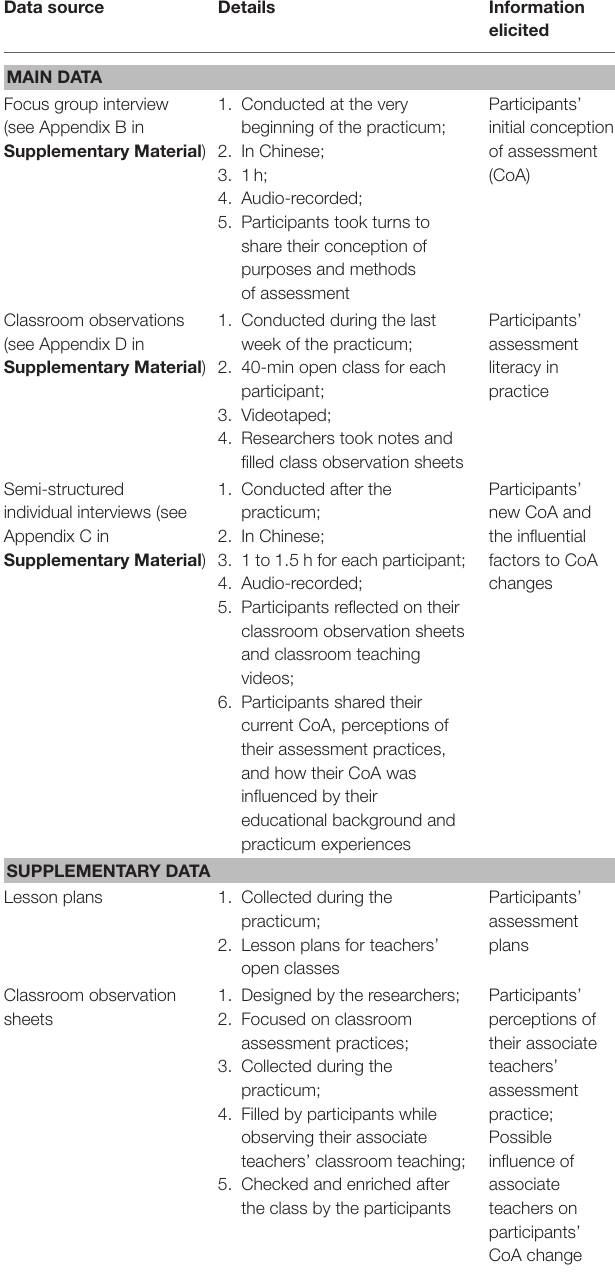
TABLE 1 | Demographic information of the participants and associate teachers. Participants Gender Associate teachers